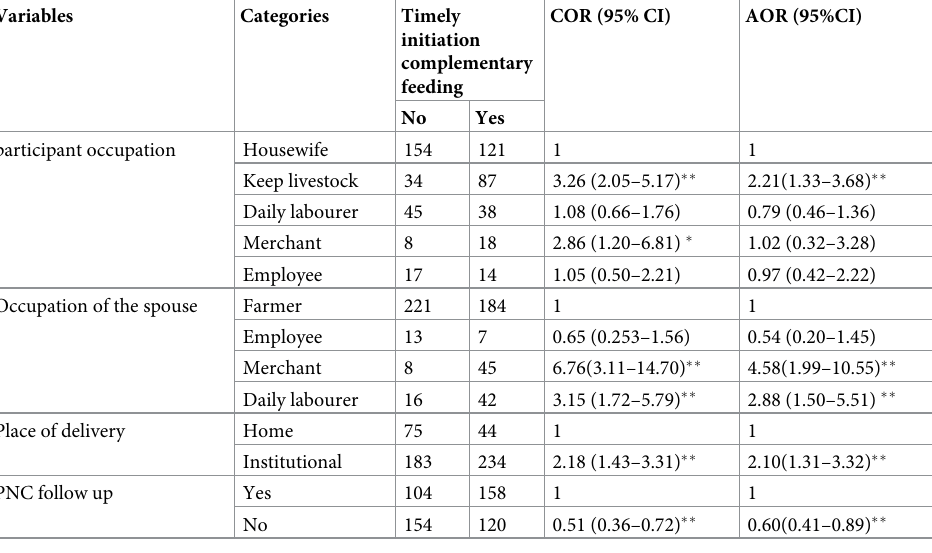
Table 3. Factors associated with timely initiation of complementary feeding among mothers who had 6–24 months children in farta